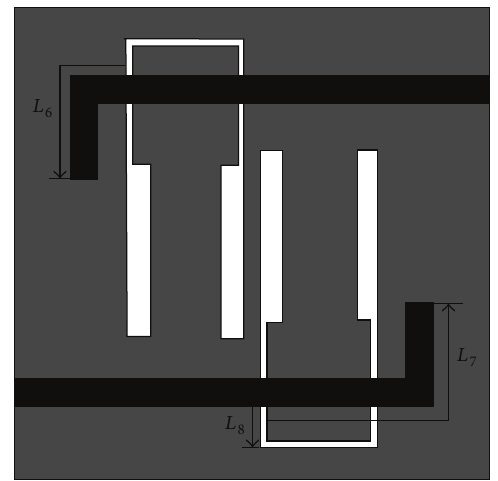
Figure 2: Top view of the proposed DGS filter.